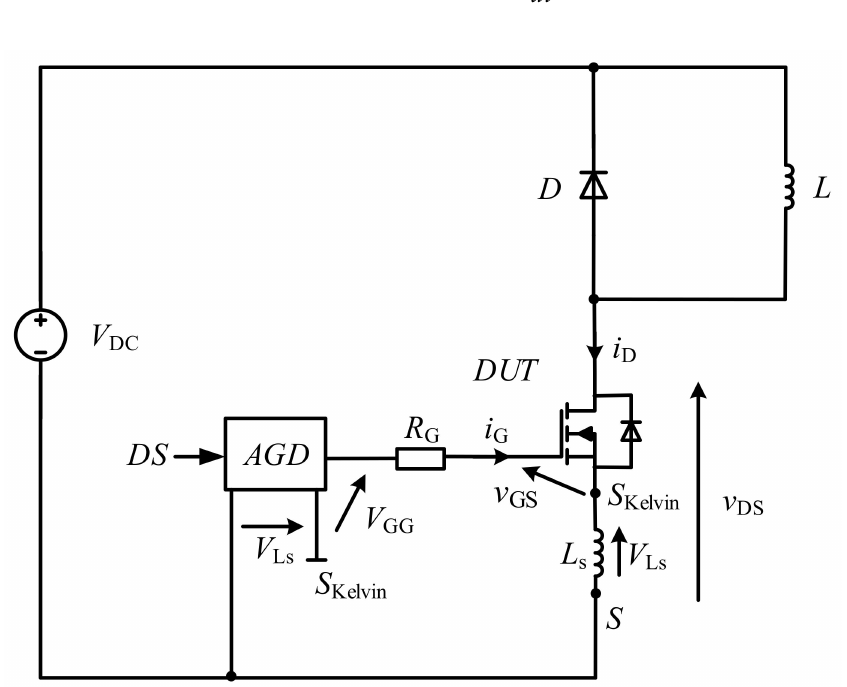
Figure 1. SiC MOSFET (DUT) in the double-pulse test (DPT) setup with the active gate driver (AGD) in which the feedback loop is based on the parasitic source inductance voltage ( V Ls ). V GG —gate voltage, R G —gate resistance, S Kelvin —Kevin source, i D —drain current, v DS —drain-source voltage, L S —parasitic inductance, v GS —gate-source